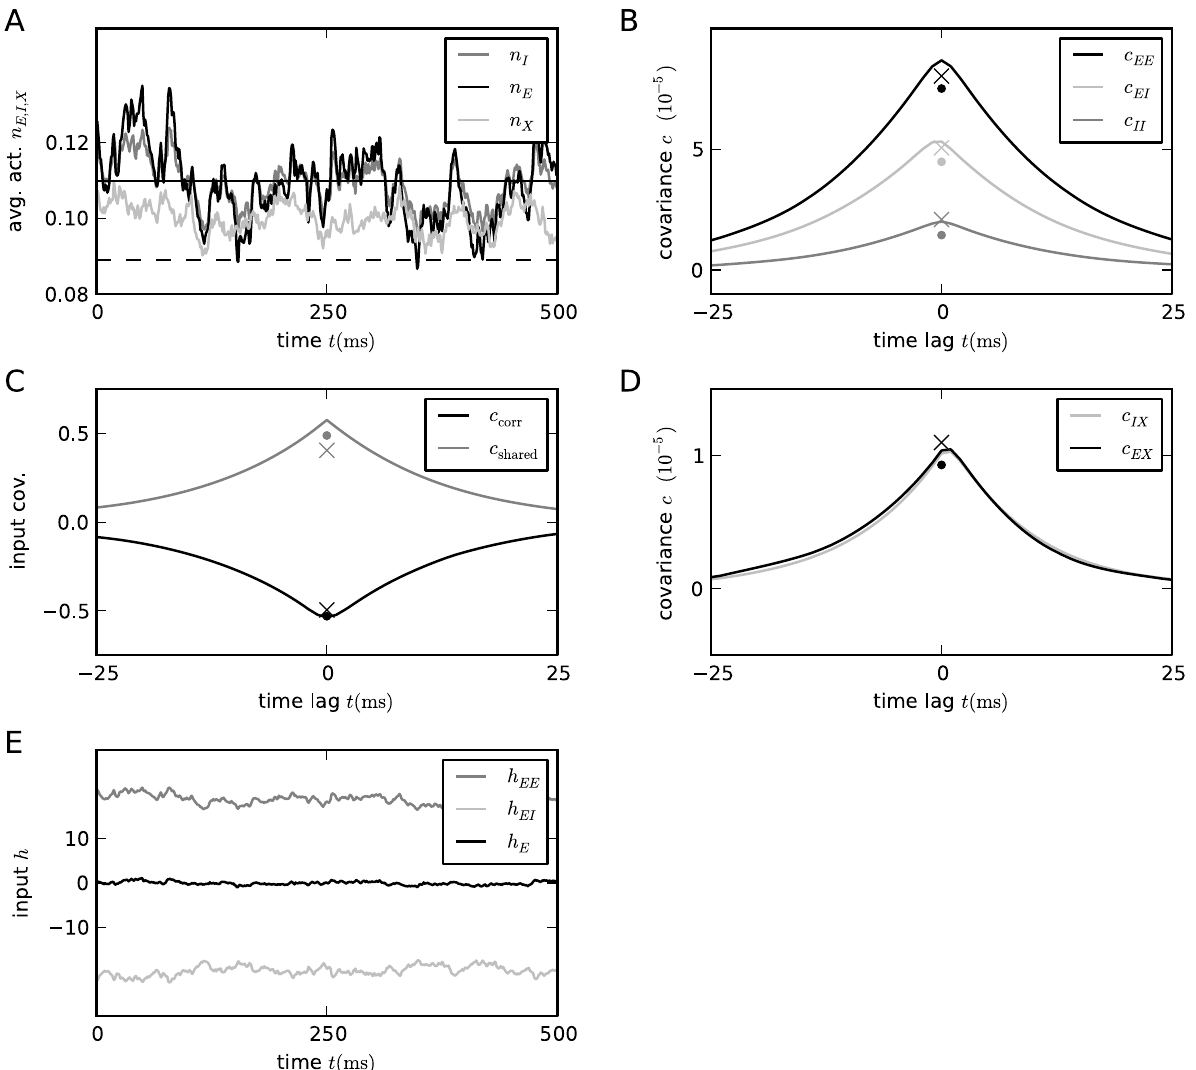
p p , J a I ~{ 10 = ffiffiffiffiffi N depending